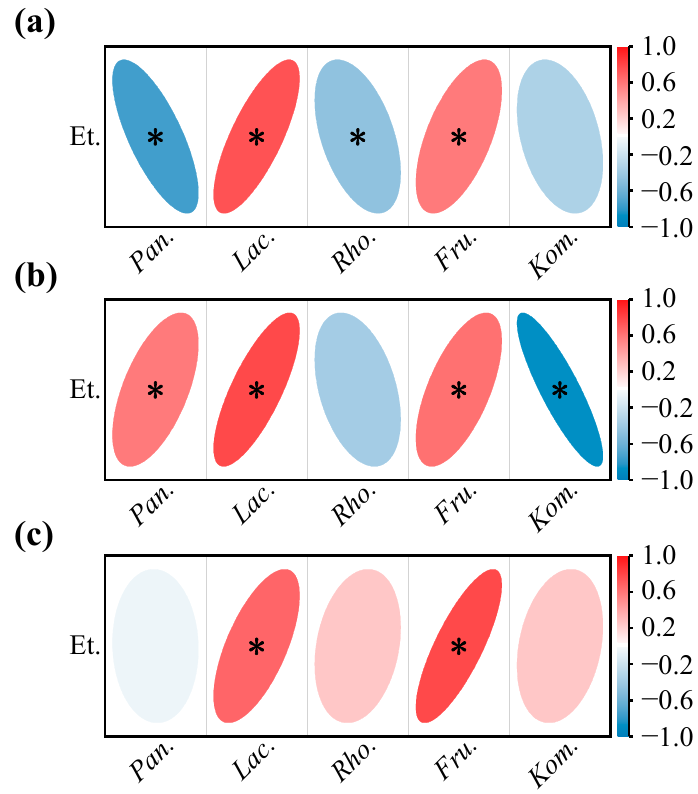
Figure 9. Correlation analysis between core bacteria and ethanol in ( a ) YC sub-region, ( b ) YQY sub-region, and ( c ) QTX sub-region. A red ellipse with an asterisk represents a significantly positive correlation (Spearman’s rank test, p < 0.05), while a blue ellipse with an asterisk represents a significantly negative correlation (Spearman’s rank test, p < 0.05). Et., ethanol; Pan. , Pantoea ; Lac. , Lactobacillus ; Rho. , Rhodococcus ; Fru. , Fructobacillus ; Kom. , Komagataeibacter . Notably, the evolutionary patterns of Lactobacillus and Fructobacillus were significantly and positively correlated with the accumulation of ethanol in all fermentations of grapes from three sub-regions (Figure 9a–c), indicating that they were not suppressed by ethanol and remained active at the late stages of